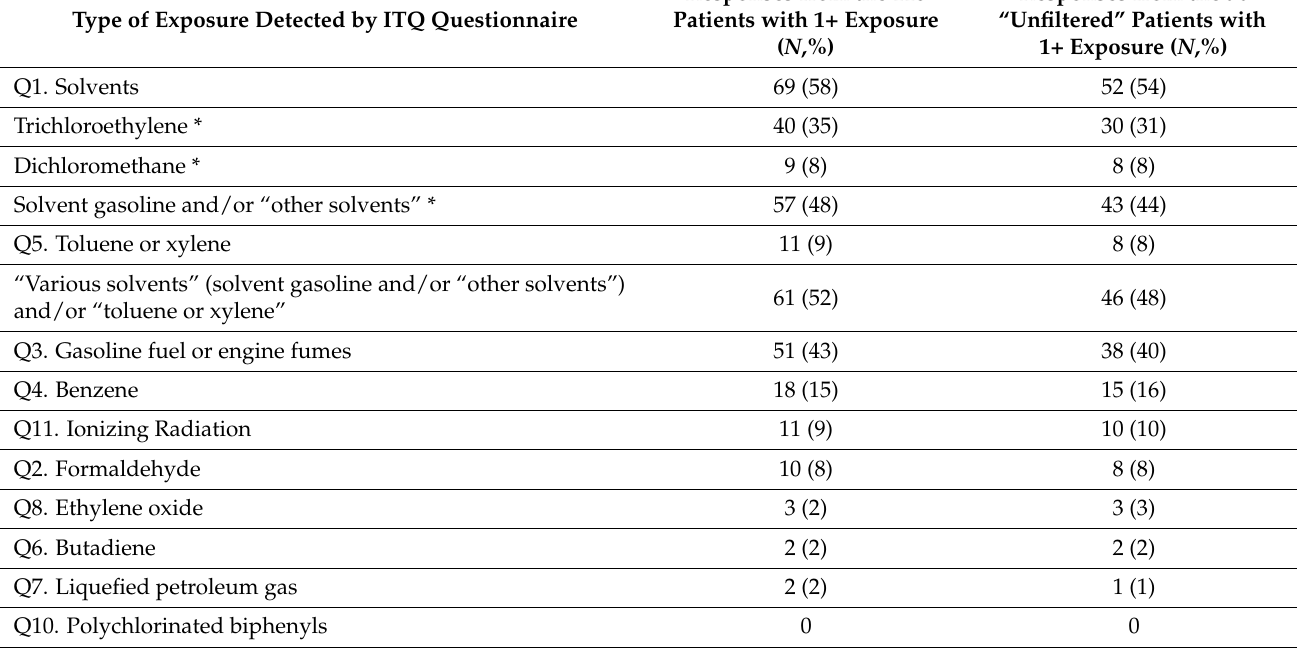
Table 3. Responses to the 18 questions of the ITQ questionnaire in patients with at least one positive response, RHELYPRO Study